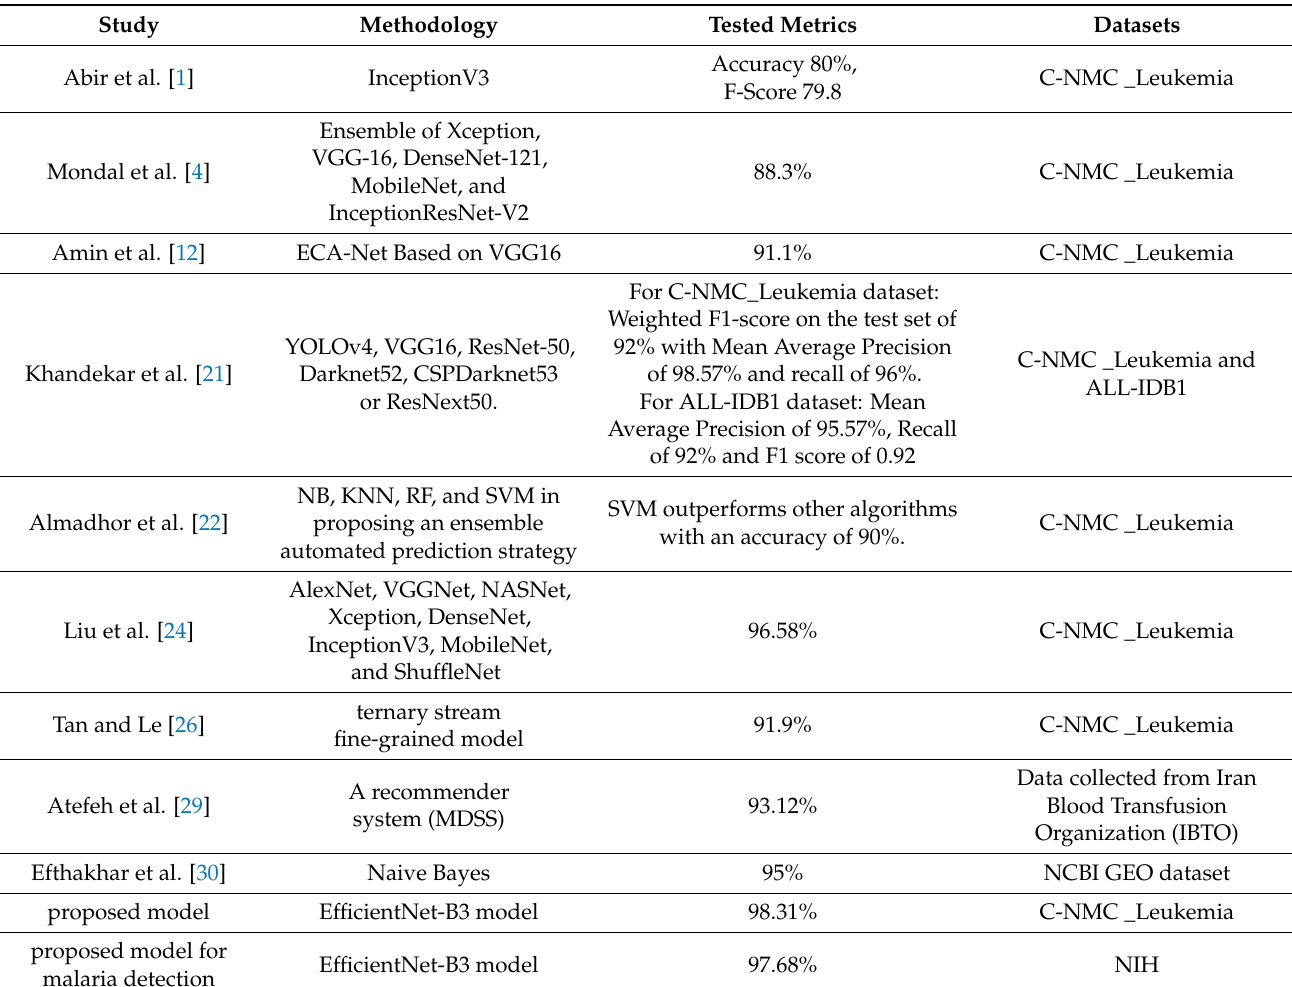
Table 8. The comparison results between the proposed model and other recent